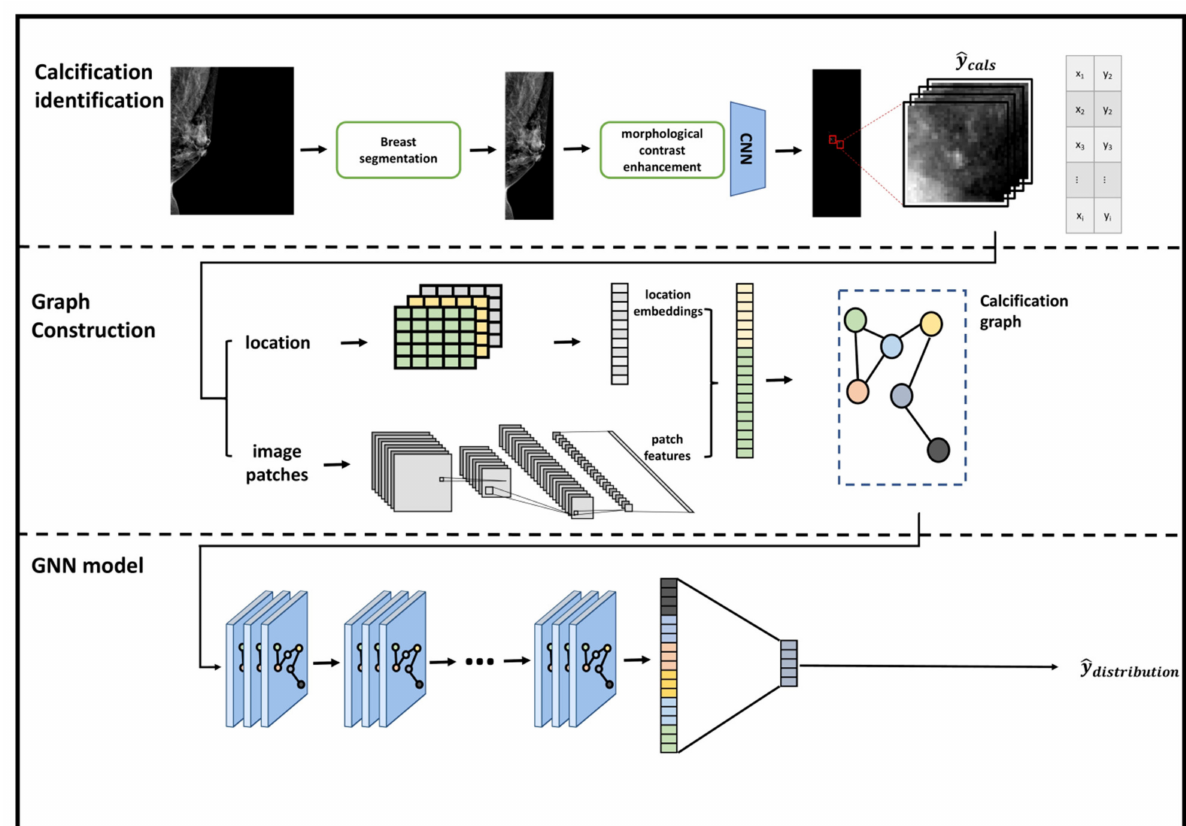
Figure 2. Overview of proposed graph neural network model